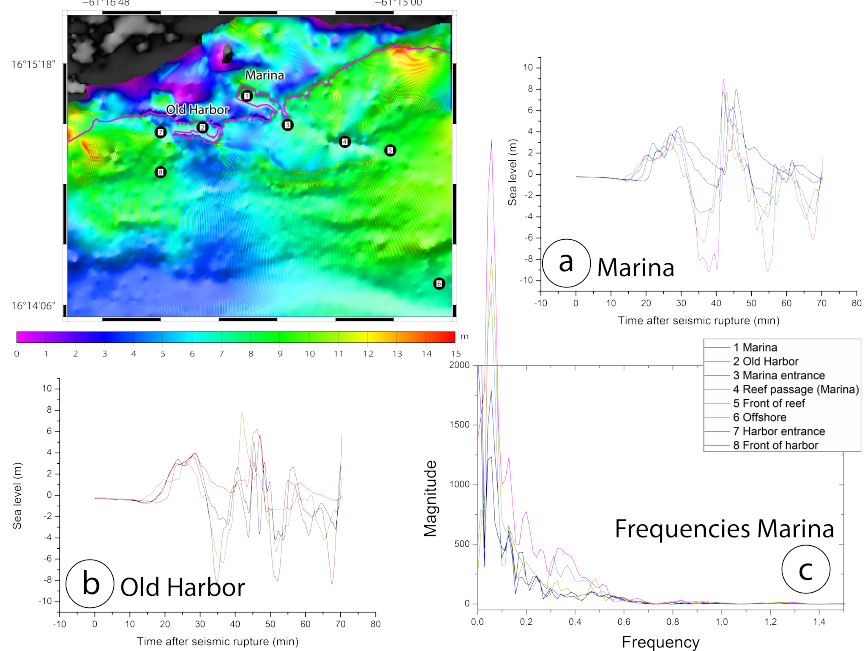
Fig. 10. Maximum water depths illuminated by a bathymetric gradient and inundation limit obtained on Grid 4 (Saint-Franc¸ois) after one hour of tsunami propagation. The color scale is different from Fig. 9. Eight synthetic tide gages have been located on this grid and symbolized with numbers within a black circle. Synthetic gage records are shown in (a) for the Marina profile and (b) for the Old Harbor profile. (c) Represents the frequency analysis of the gage records for the Marina